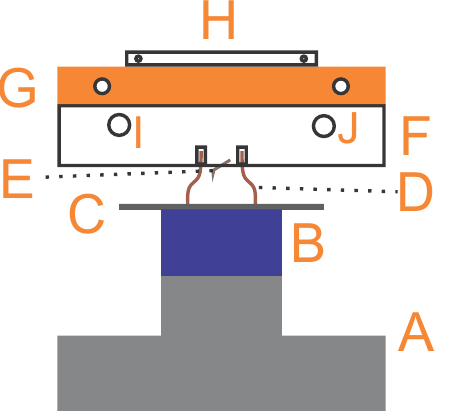
Figure 3. Scheme of the front view of the AFM and the mEC: (A) piezoelectric, (B) Peltier element, (C) mica substrate, (D) sil- icone o-ring, (E) AFM tip, (F) fluid’s glass cell, (G) copper cooler, (H) heating resistance, (I) outlet of gases and temperature–humidity sensor, and (J) inlet of gases.